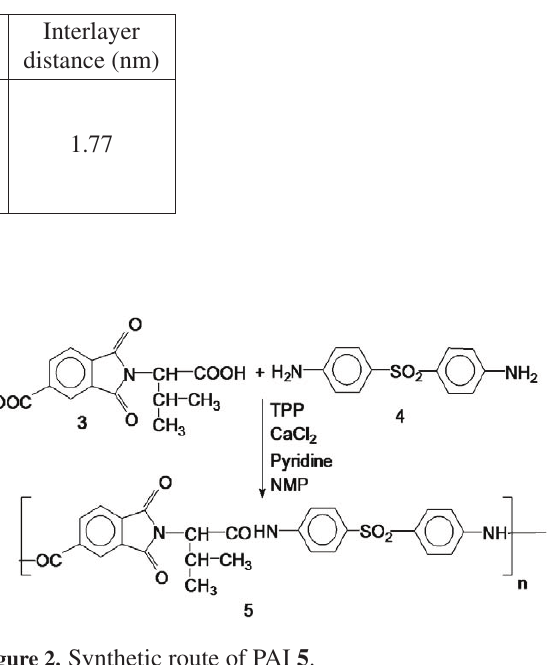
Figure 2. Synthetic route of PAI 5